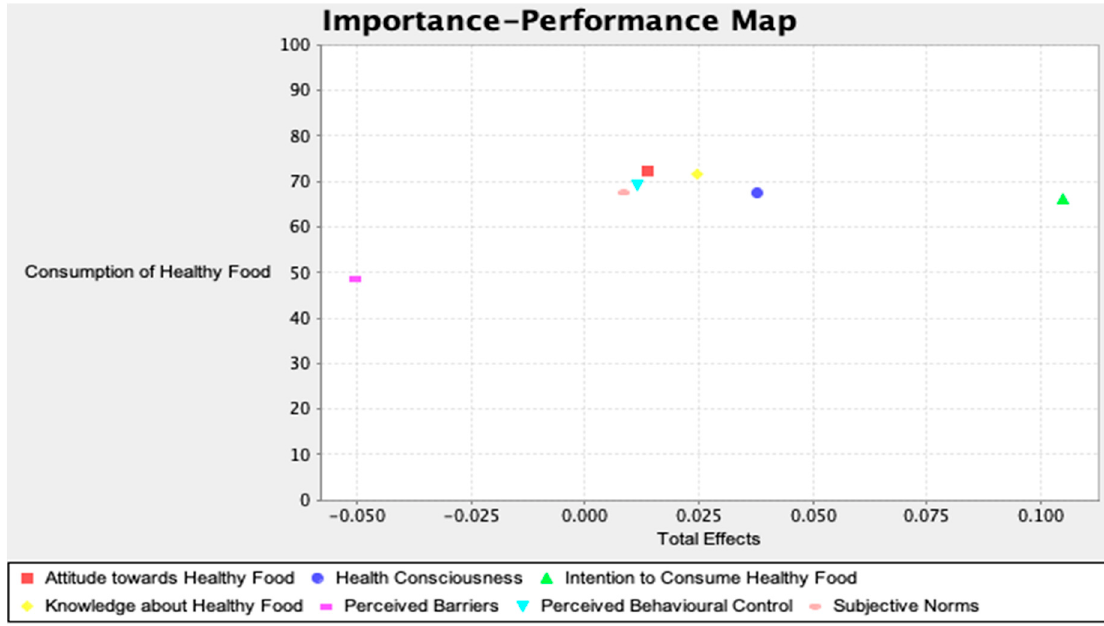
Table 8. Performance and total effects. Target Construct